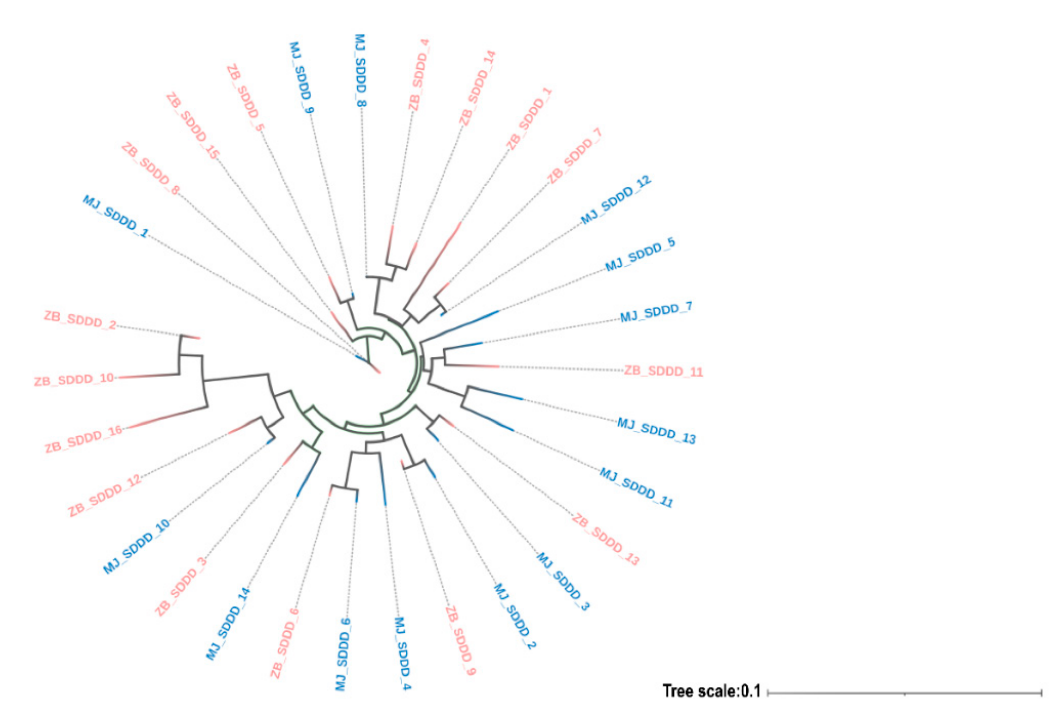
Figure 3. The minimum spanning network of 30 L. kasmira individuals.